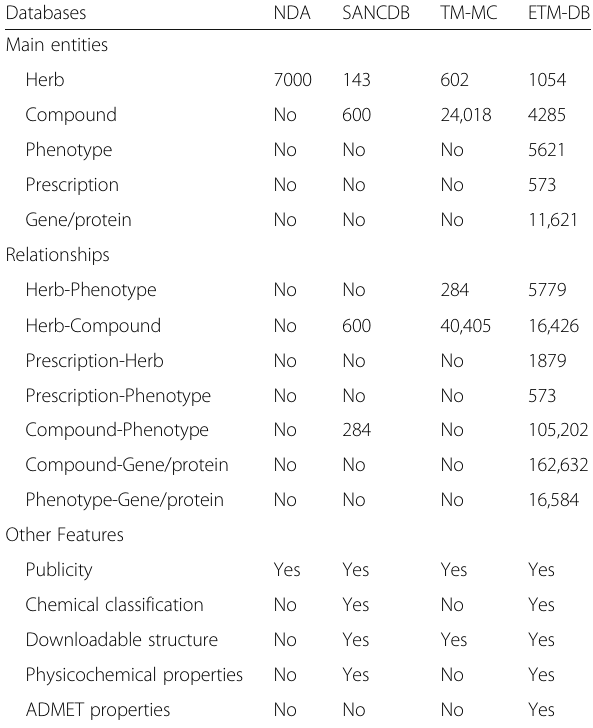
Table 1 Comparison of main entities, relationships, and other features in ETM-DB with related natural product databases